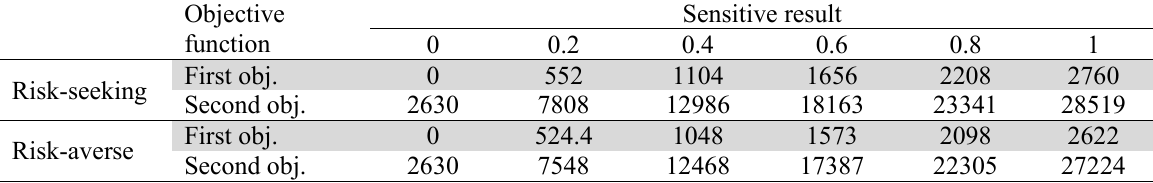
Results of rate of return sensitivity analysis for risk-averse and risk-seeking decision makers Objective function